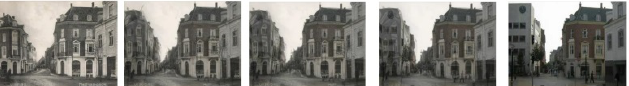
Figure 1. Nearly 100 years of a cityscape shown in a few seconds via an animated morph of two still images. Framegrabs from film produced by the author and Lisbeth Aagaard Larsen / Viborg Museum, Denmark. Used with